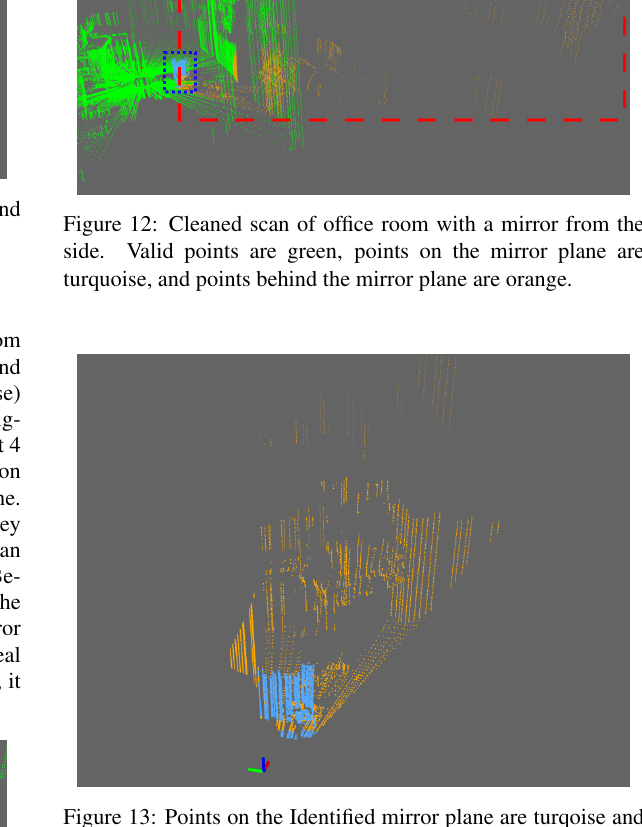
Figure 13: Points on the Identified mirror plane are turqoise and corrupted points behind the mirror are